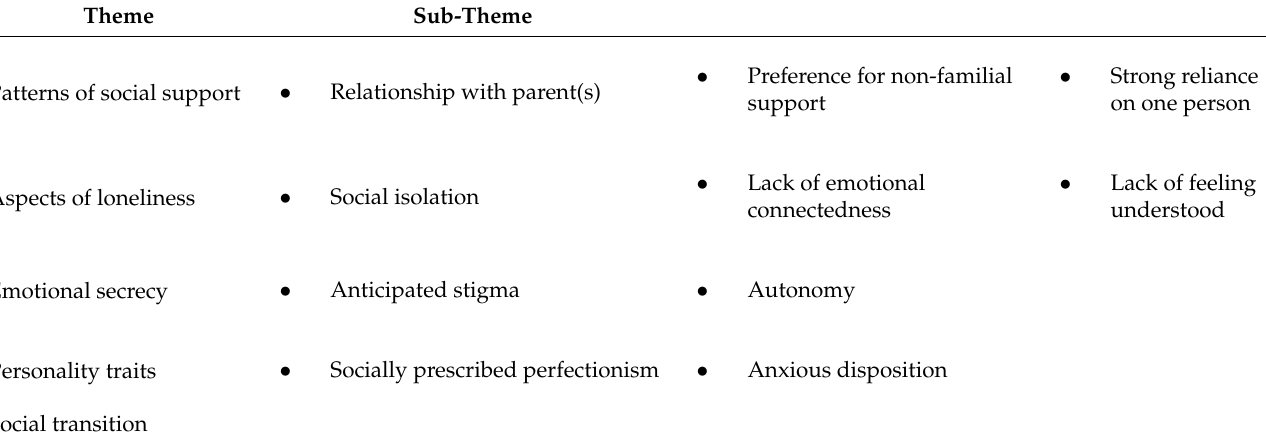
Table 2. Themes and subthemes